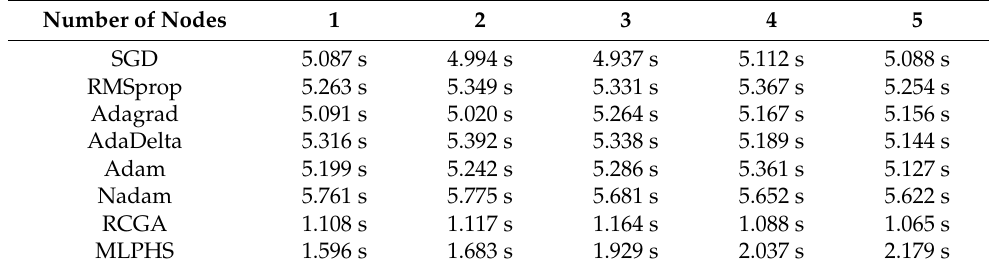
Table 3. Average time required for each optimizer according to the number of nodes.